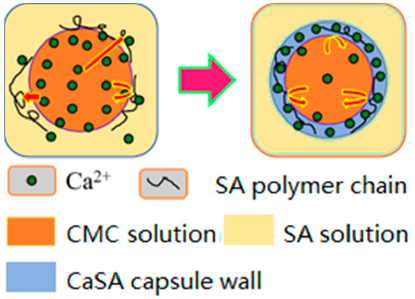
Figure 13. Formation of the wall of mm-CaSA-Caps and its barrier mechanism.